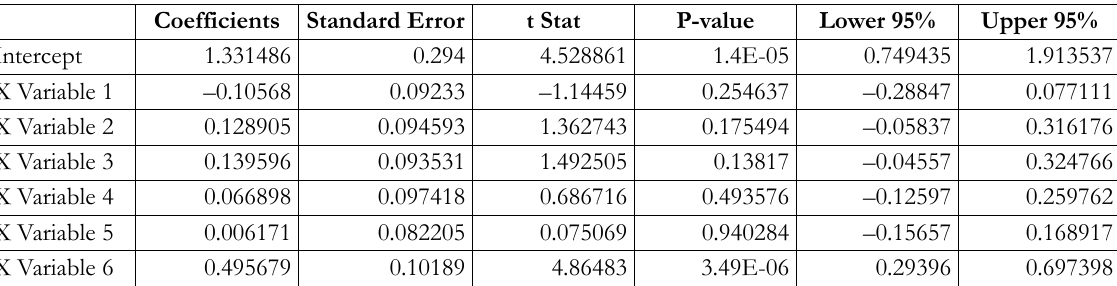
Table 18. Multiple Regression Summary of Support services against increased usage of ICTs